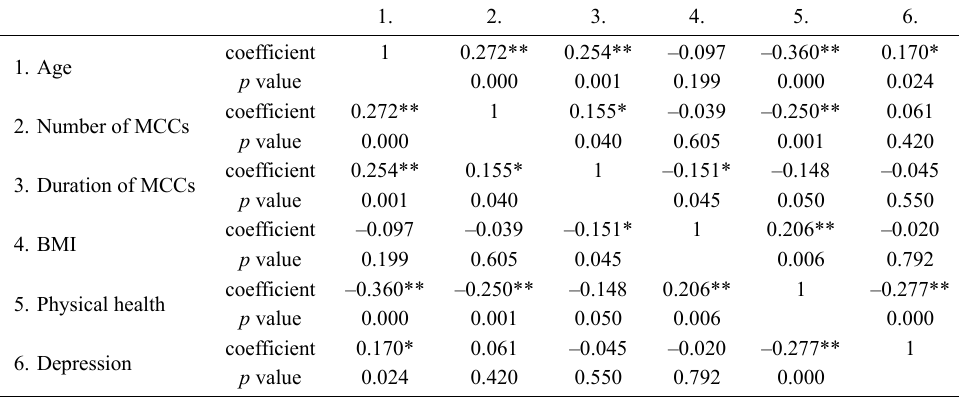
Table 2. Correlations of the observed variables in the male group (n =